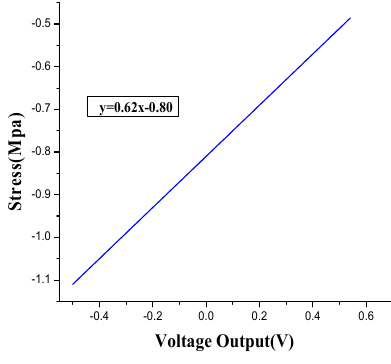
Figure 8. The fitting line at a circle of 0.16 s.